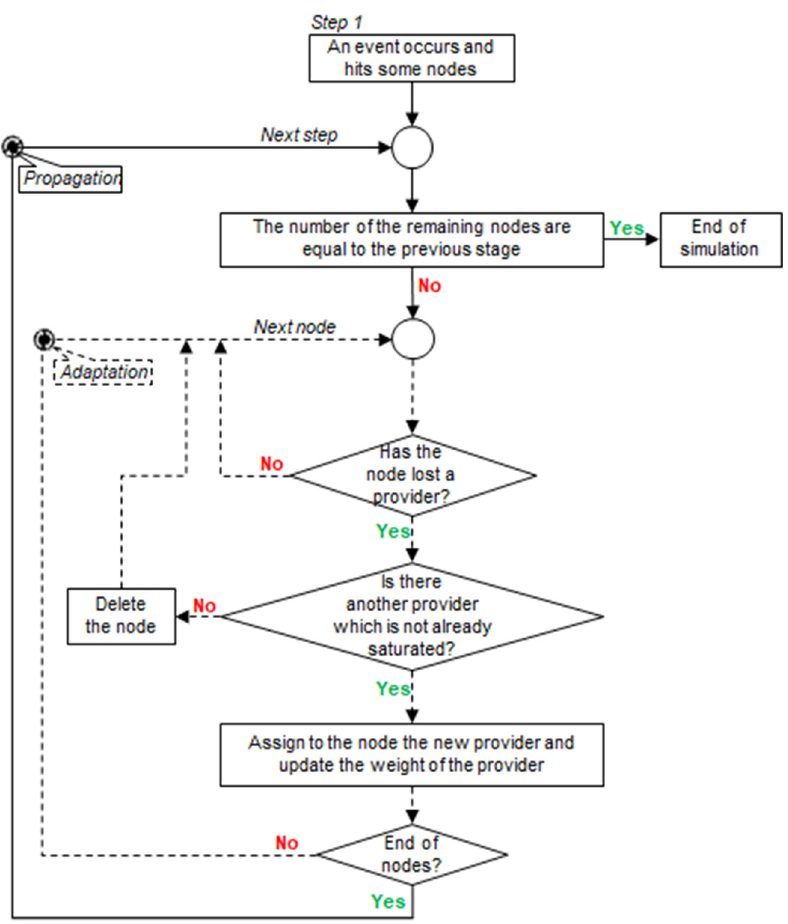
Figure 4. High-level description of the propagation process.